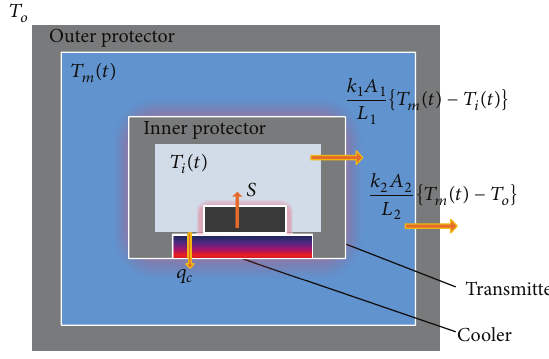
Figure 1: Instrument transmitter protecting